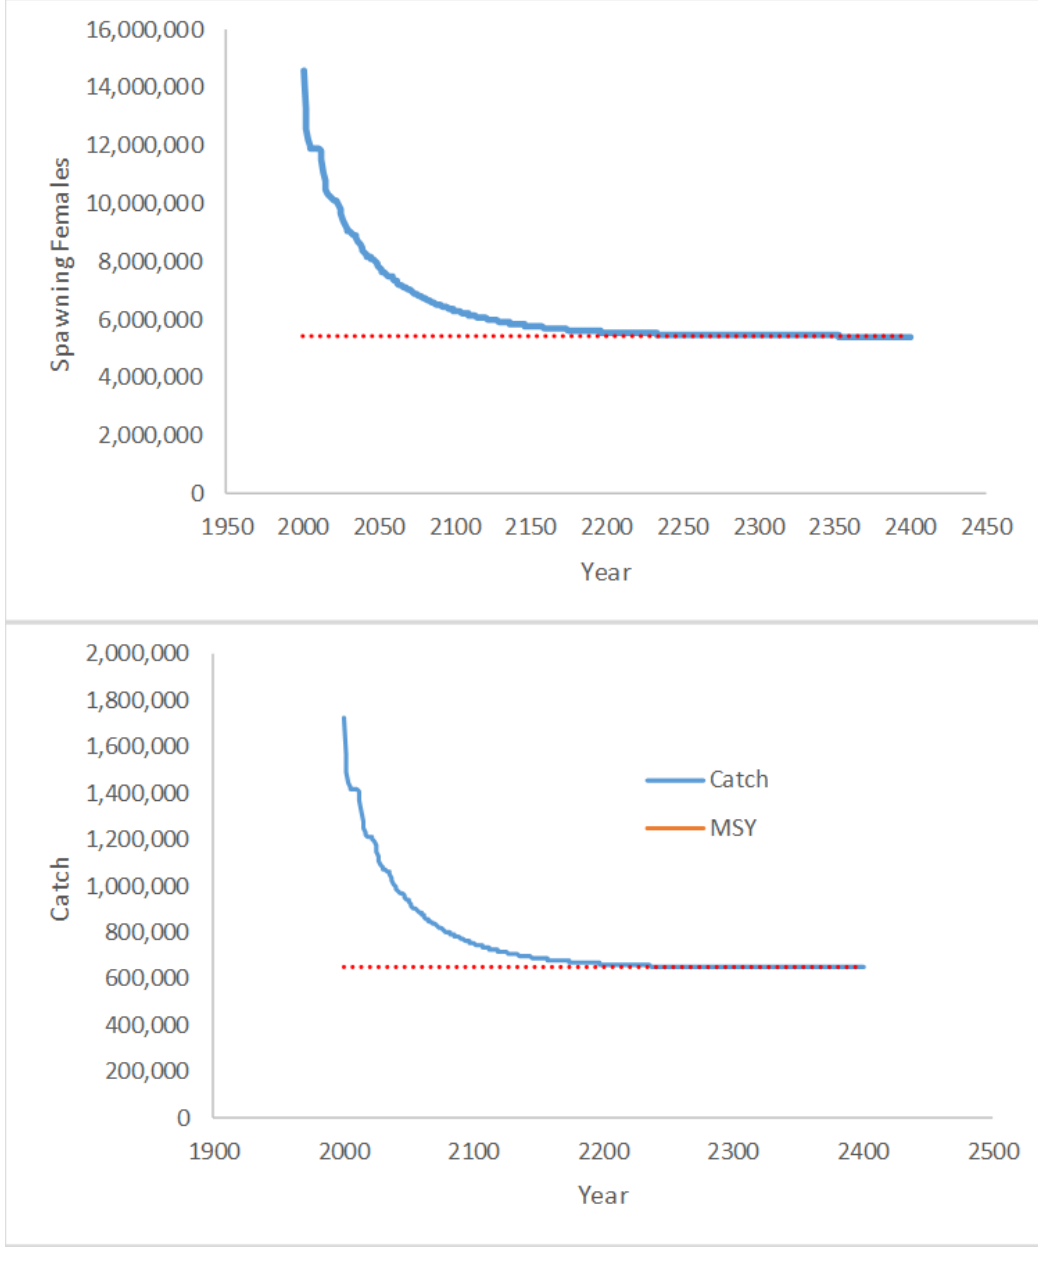
Figure 90. Projections of the horseshoe crab operating model under F MSY (0.1613) showing where the population asymptotes at B MSY (5,433,439) and where catch asymptotes at MSY (647,609